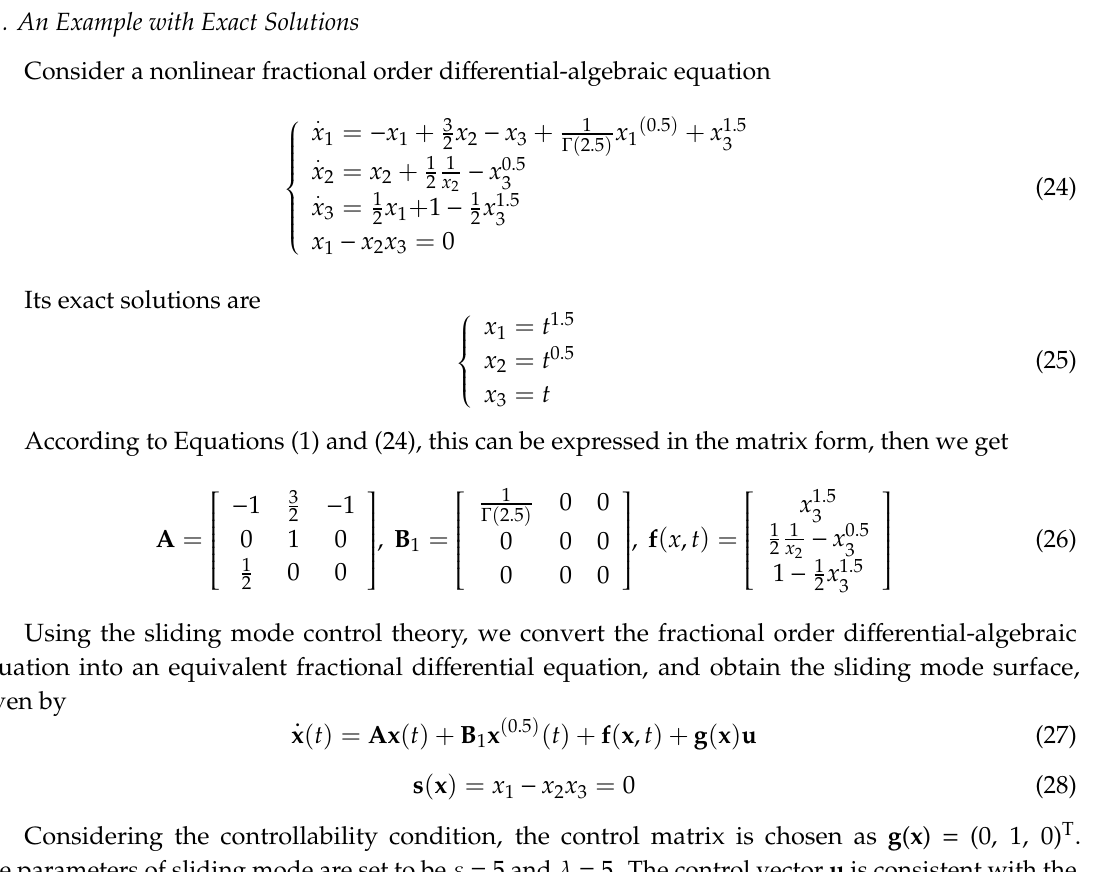
Figure 2. Percentage differences between the exact solutions and the present method. Next, the effect of time step on the accuracy of the present method is studied. Figures 3–5 show the percentage difference between the numerical solutions and the exact solutions for different time steps, h = 0.001, 0.005, 0.01 and 0.02. As shown in the figures, for all cases of time steps, the percentage difference increases when t → 1, but within 5% when 5 < t < 35. For the case of t > 25, the percentage difference increases with the increase in t . Note that for all solutions, the larger the step is, the larger the error is. For the case of t > 35, the accuracy of small step is still good (when h = 0.001, the maximum error at t = 50 is about 1%), while the accuracy of large step drops sharply. Figure 3. Percentage difference of x 1 between the exact solutions and the present method for different time steps h .